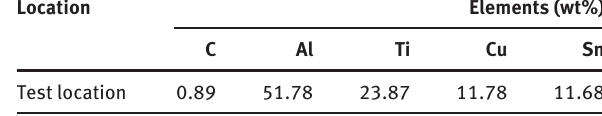
Figure 3 Microhardness distribution of the composite coating on